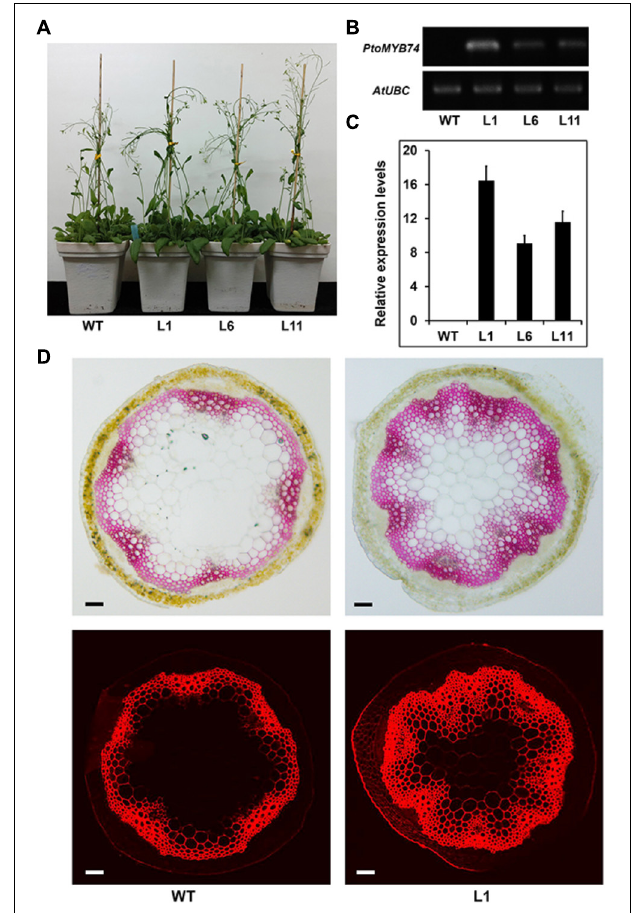
FIGURE 4 | Phenotypes of transgenic Arabidopsis overexpressing PtoMYB74 . (A) Representative 30-day-old wild-type and transgenic lines (L1, L6, and L11). (B,C) The relative expression levels of PtoMYB74 in different lines (L1, L6, and L11). Semi-quantitative RT-PCR analyses of PtoMYB74 in transgenic Arabidopsis plants (B) ; Quantitative RT-PCR analyses of PtoMYB74 in transgenic Arabidopsis plants (C) . (D) The phloroglucinol-HCl staining and lignin autofluorescence in wild-type and PtoMYB74 overexpression line (L1). Bars: C = 500 µ